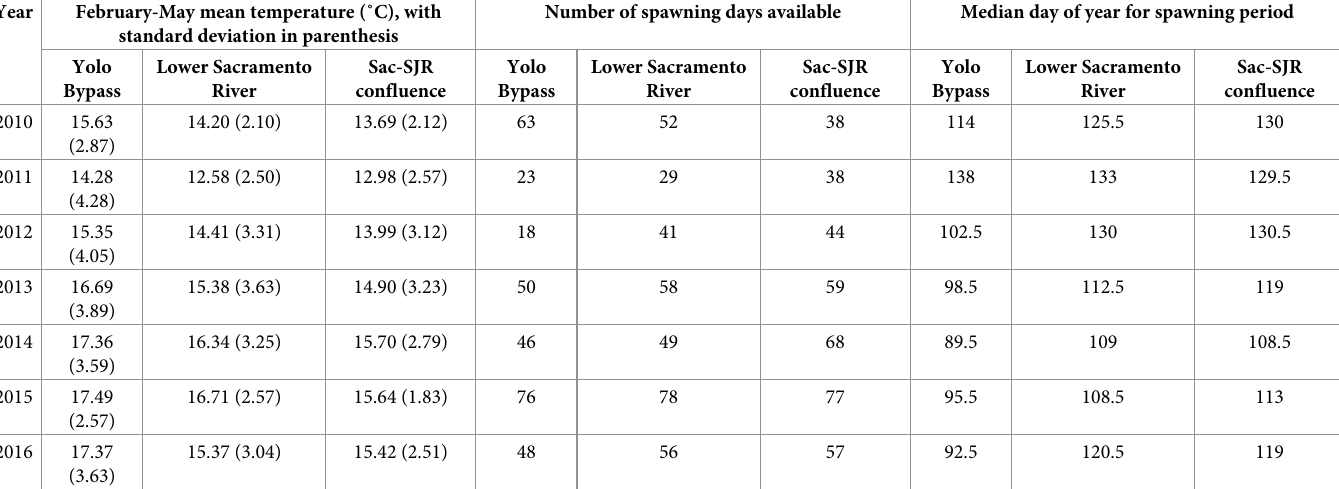
Table 4. Summary of February-May Delta Smelt-relevant temperature metrics comparing the Yolo Bypass Toe Drain, lower Sacramento River near the city of Rio Vista, and the confluence between Sacramento and San Joaquin Rivers (Sac-SJR confluence) for the duration of the study period. Values shown are mean tempera- ture from February to May for each year, the number of spawning days available for Delta Smelt for each period based on temperature (15–20˚C), and the median day of year for each spawning period (where January 1st = 1). Year February-May mean temperature (˚C), with standard deviation in